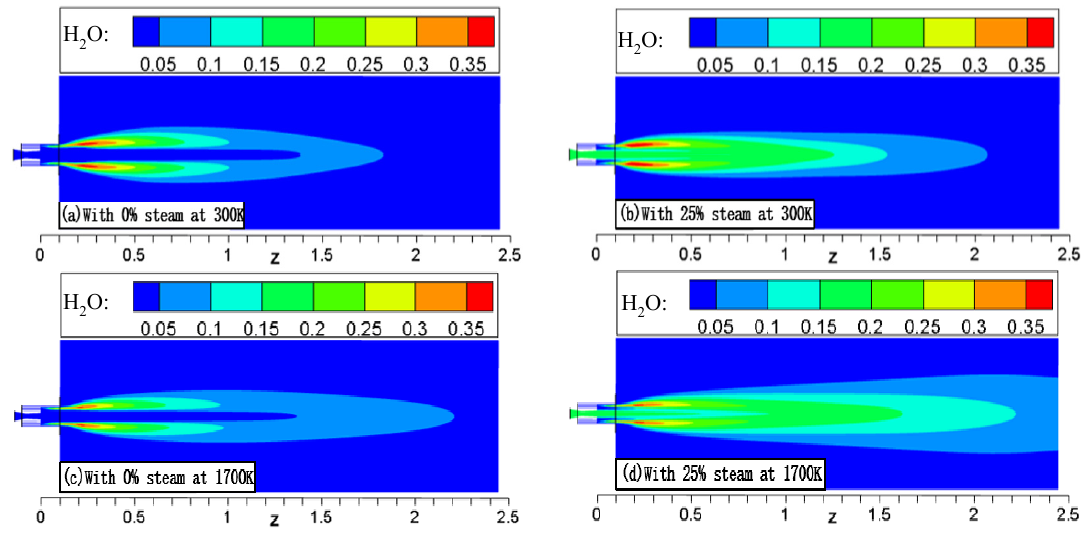
Figure 16. Longitudinal cross-sectional distributions of H 2 O in the coherent supersonic jets under different conditions: ( a ) 0% steam and 100% oxygen at 300 K; ( b ) 25% steam and 75% oxygen at 300 K; ( c ) 0% steam and 100% oxygen at 1700 K; and ( d ) 25% steam and 75% oxygen at 1700 K.